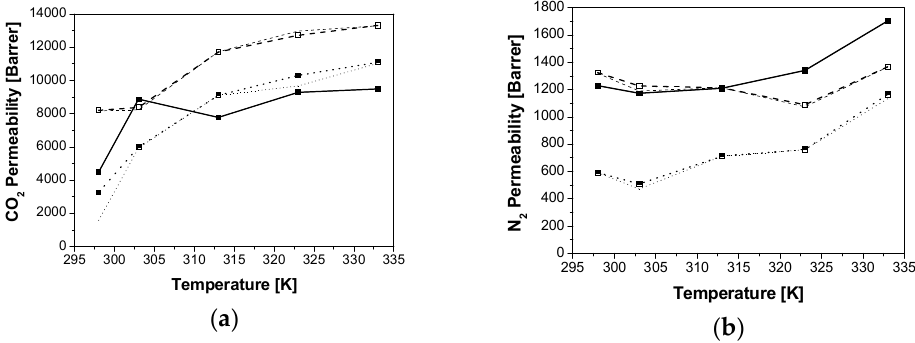
Figure 5. Effect of temperature and zeolite loading on the CO 2 ( a ) and N 2 ( b ) permeability through Figure 4. Effect of temperature and zeolite loading on the CO 2 ( a ) and N 2 ( b ) permeability through Figure 4. Effect of temperature and zeolite loading on the CO 2 ( a ) and N 2 ( b ) permeability through Figure 4. Effect of temperature and zeolite loading on the CO 2 ( a ) and N 2 ( b ) permeability through LTA/PTMSP MMMs: Thin lines correspond to the reduced mobility modified model and thick lines CHA/PTMSP MMMs: Thin lines correspond to the reduced mobility modified Maxwell model and CHA/PTMSP MMMs: Thin lines correspond to the reduced mobility modified Maxwell model and CHA/PTMSP MMMs: Thin lines correspond to the reduced mobility modified Maxwell model and to the extended modified Maxwell model. Dash, dot and continuous patterns, and void, half-filled thick lines to the extended modified Maxwell model. Dash, dot and continuous patterns, and void, thick lines to the extended modified Maxwell model. Dash, dot and continuous patterns, and void, thick lines to the extended modified Maxwell model. Dash, dot and continuous patterns, and void, and full symbols, refer to 5 wt %, 10 wt % and 20 wt % zeolite loading, respectively. half-filled and full symbols, refer to 5 wt %, 10 wt % and 20 wt % zeolite loading, respectively. half-filled and full symbols, refer to 5 wt %, 10 wt % and 20 wt % zeolite loading, respectively. half-filled and full symbols, refer to 5 wt %, 10 wt % and 20 wt % zeolite loading, respectively.